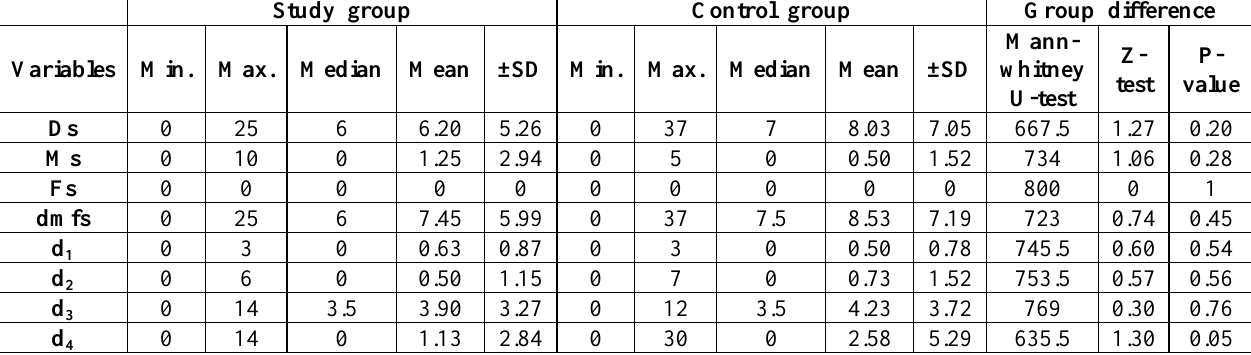
Table 1: Caries experience and caries severity for primary dentition among study and